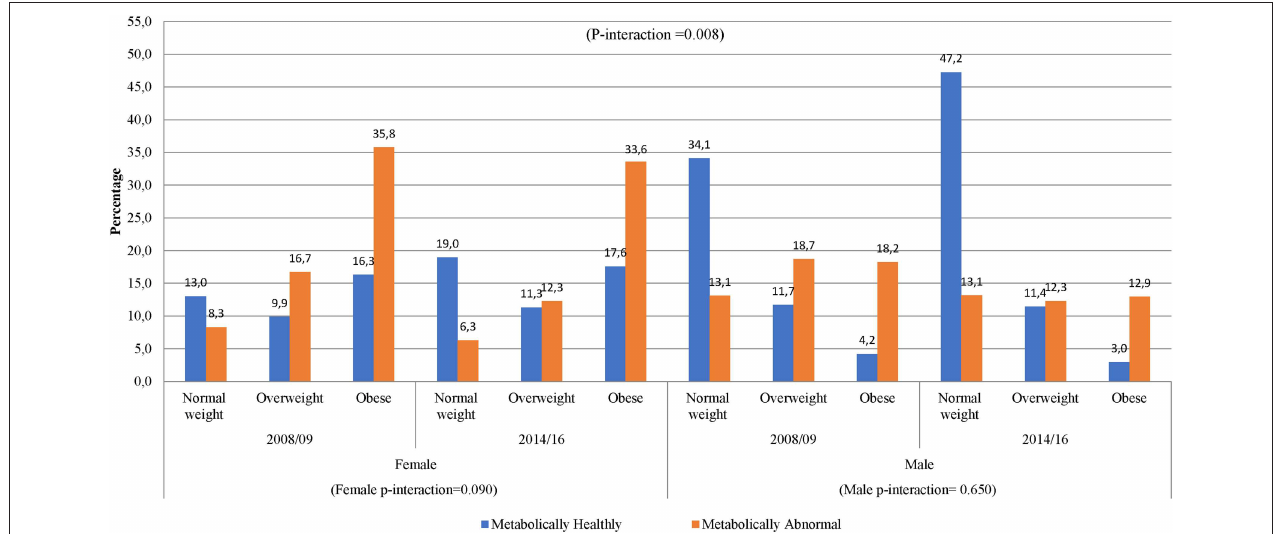
FIGURE 3 | Distribution of obesity phenotypes per year of study and gender. In 2008/09, women had shown an increase from NWMH, 13.0–16.3% in MHO, while in 2014/16 there was a slight decrease from 19.0% in NWMH to 17.6% in MHO (women p-interaction = 0.090). Men had shown a decrease of 8-fold in NWMH to MHO in 2008/09, while 2014/16 had shown a 15-fold decrease (men p-interaction = 0.650).